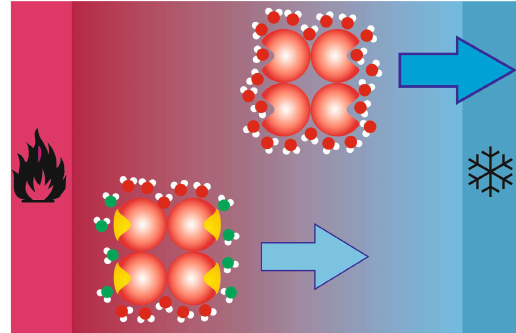
Fig. 2. Here it can be seen that the ligand free STV is more likely to accumulate in colder areas than the ligand bound STV+B complex. This is thought to be related to the higher hydrophilicity of free STV